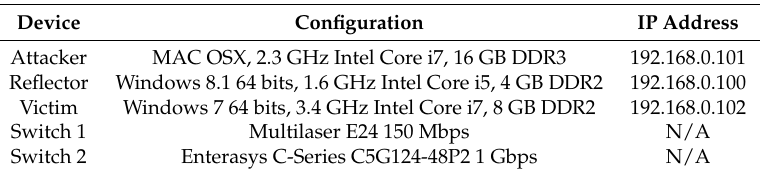
Table 8. Environment configuration.